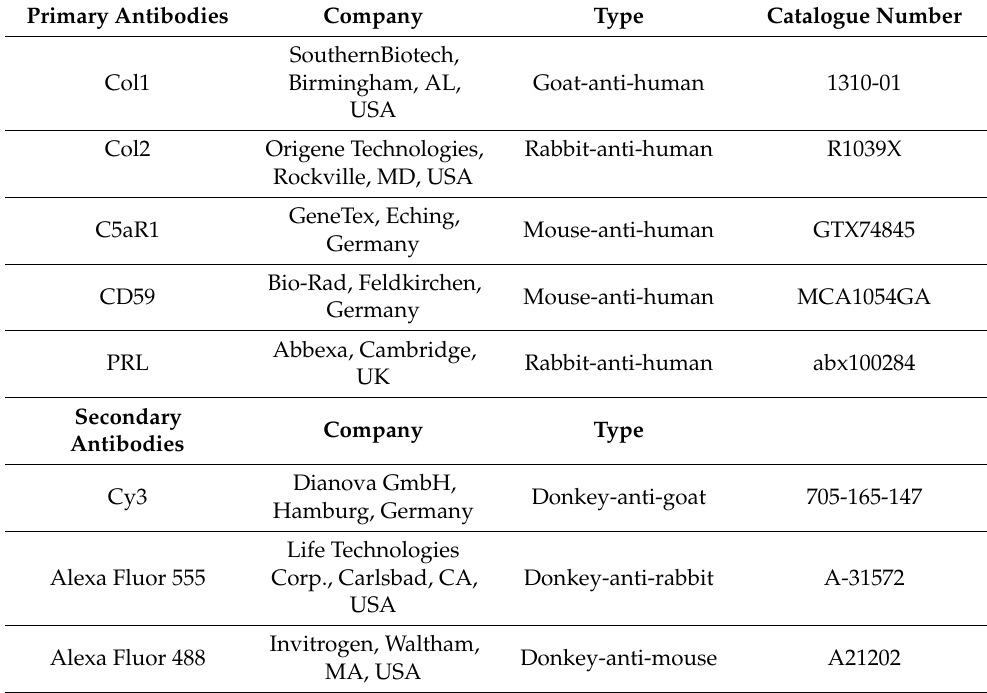
Table 2. List of applied antibodies for the immunofluorescence